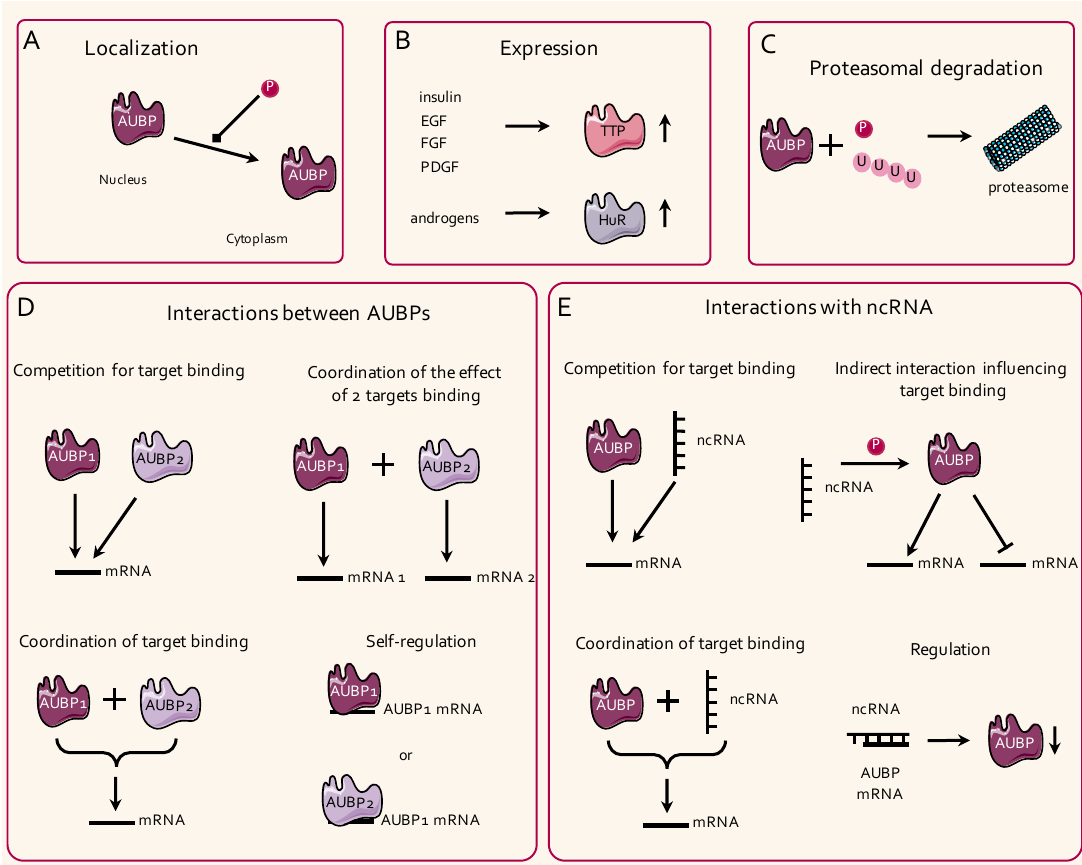
Figure 4. Regulatory mechanisms of the activity of AUBPs. ( A ) The localization and shuttling of AUBPs between the nucleus and the cytoplasm can be regulated by phosphorylation events. ( B ) The expression of AUBPs, such as TTP or HuR, is regulated by growth factors (e.g., insulin, epidermal growth factor (EGF), fibroblast growth factor (FGF), and platelet-derived growth factor (PDGF)) and androgens, respectively. ( C ) AUBPs can be targeted for proteasomal degradation by phosphorylation and/or ubiquitination. ( D ) AUBPs can compete for binding to the same mRNA (upper left panel) or can influence their respective binding to different or to the same target mRNAs (upper right and lower left panels). AUBPs can finally regulate the lifetime of their own mRNAs and of the RNAs of other AUBPs (lower right panel). ( E ) AUBPs and non-coding RNAs (ncRNAs) can compete or coordinate each other’s binding to a target mRNA (upper and lower left panels). ncRNAs can also indirectly influence the binding of AUBPs to their respective targets through intermediate mechanisms (e.g., phosphorylation events; upper right panel). Finally, ncRNAs can bind to the mRNAs of AUBPs and can regulate their protein expression levels (lower right panel).